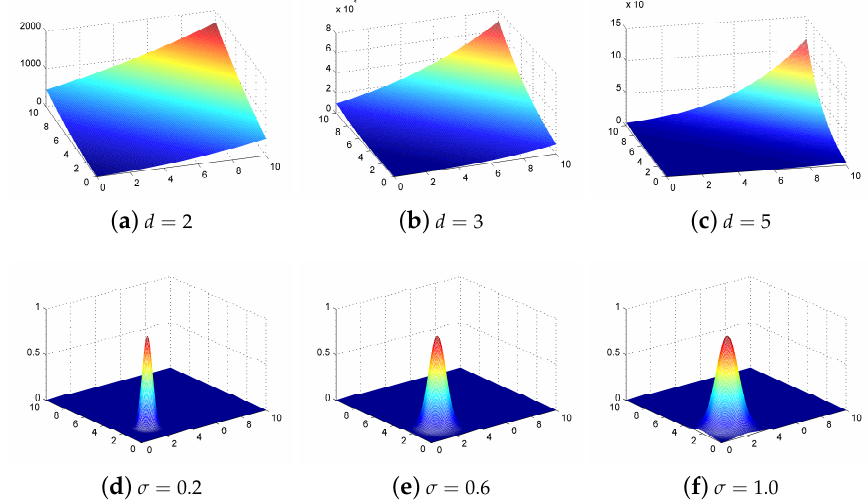
Figure 1. Polynomial and radial basis function (RBF) kernel representations. Polynomial kernels of degree ( a ) 2, ( b ) 3, and ( c ) 5; RBF kernels with the parameter σ of ( d ) 0.2, ( e ) 0.6, and ( f )